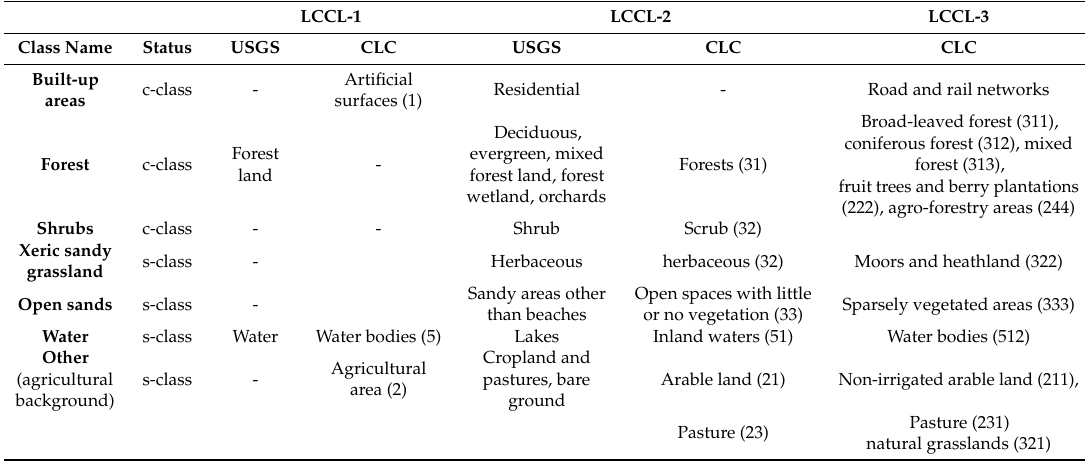
Table 2. Land cover classes used in the study. Descriptions are provided, along with references to USGS and Corine Land Cover (CLC) nomenclature. Only references that most accurately describe the case-study land cover are listed (e.g., CLC Level 1 forest is not reported because, at Level 1, forest is merged with semi-natural areas). LCCL—land-cover classification